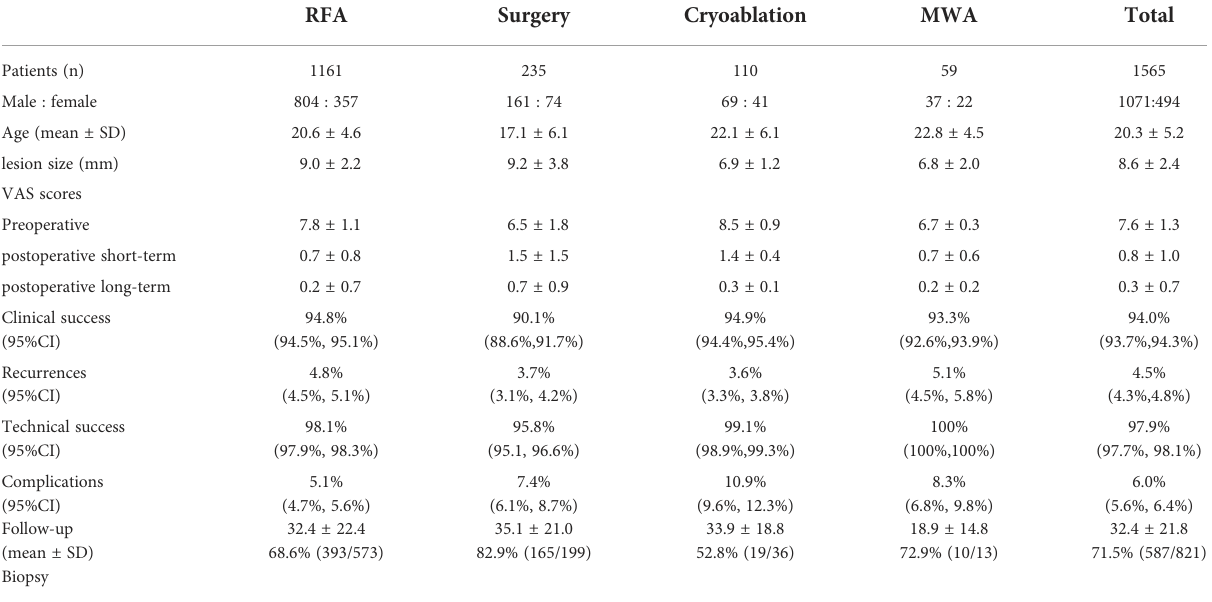
TABLE 2 Patient characteristics and outcomes. RFA Surgery